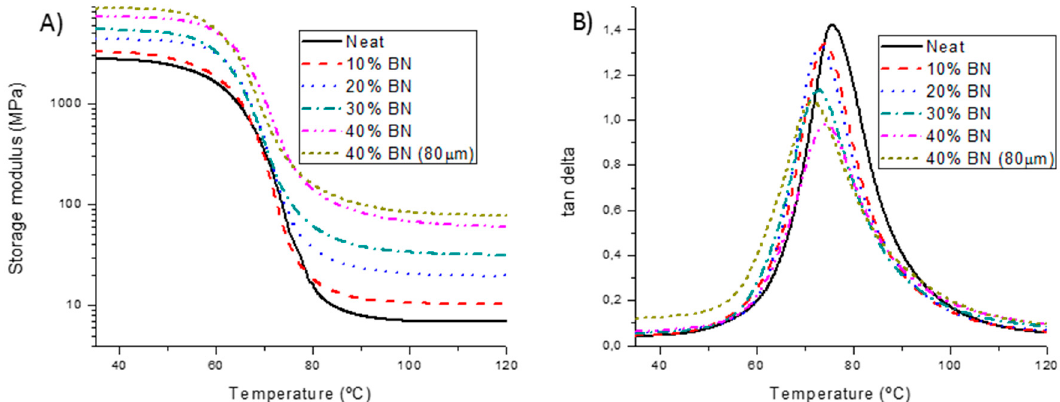
Figure 5. Variation of storage modulus ( A ) and tan δ ( B ) against temperature of the different materials prepared.